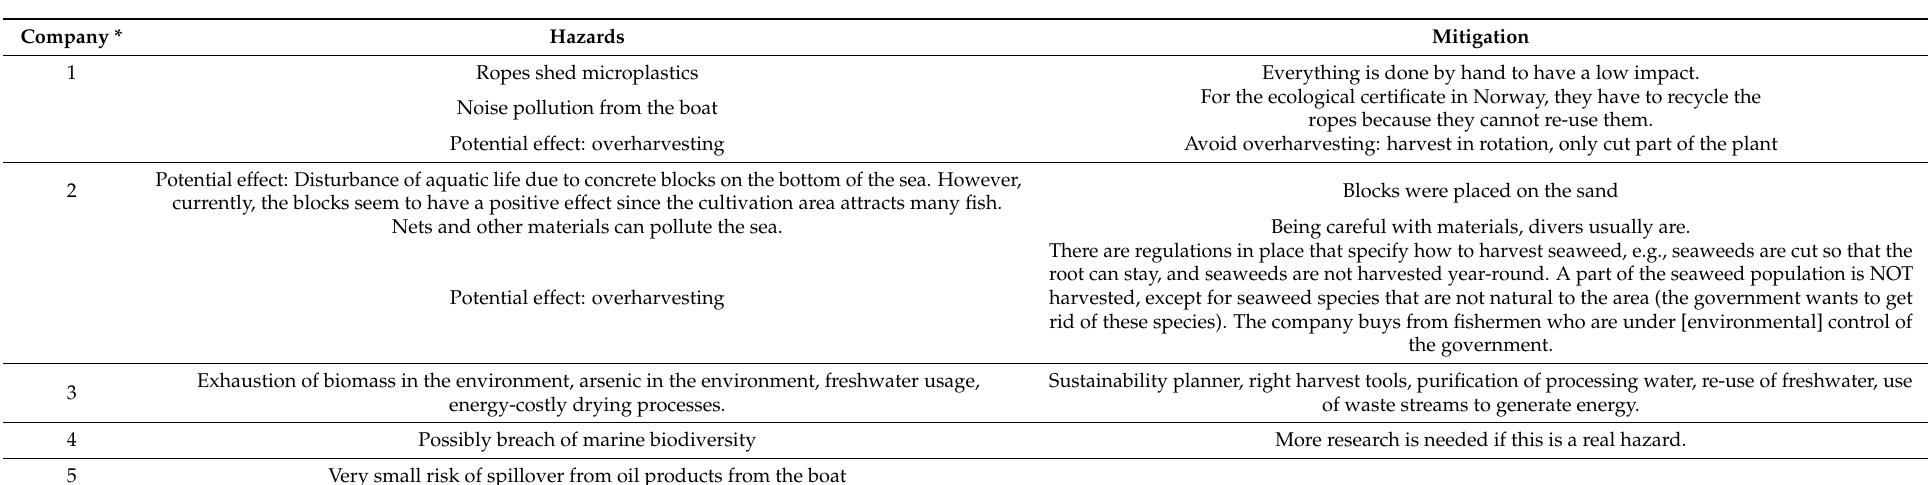
Table 5. Environmental hazards where the farm has an impact on the